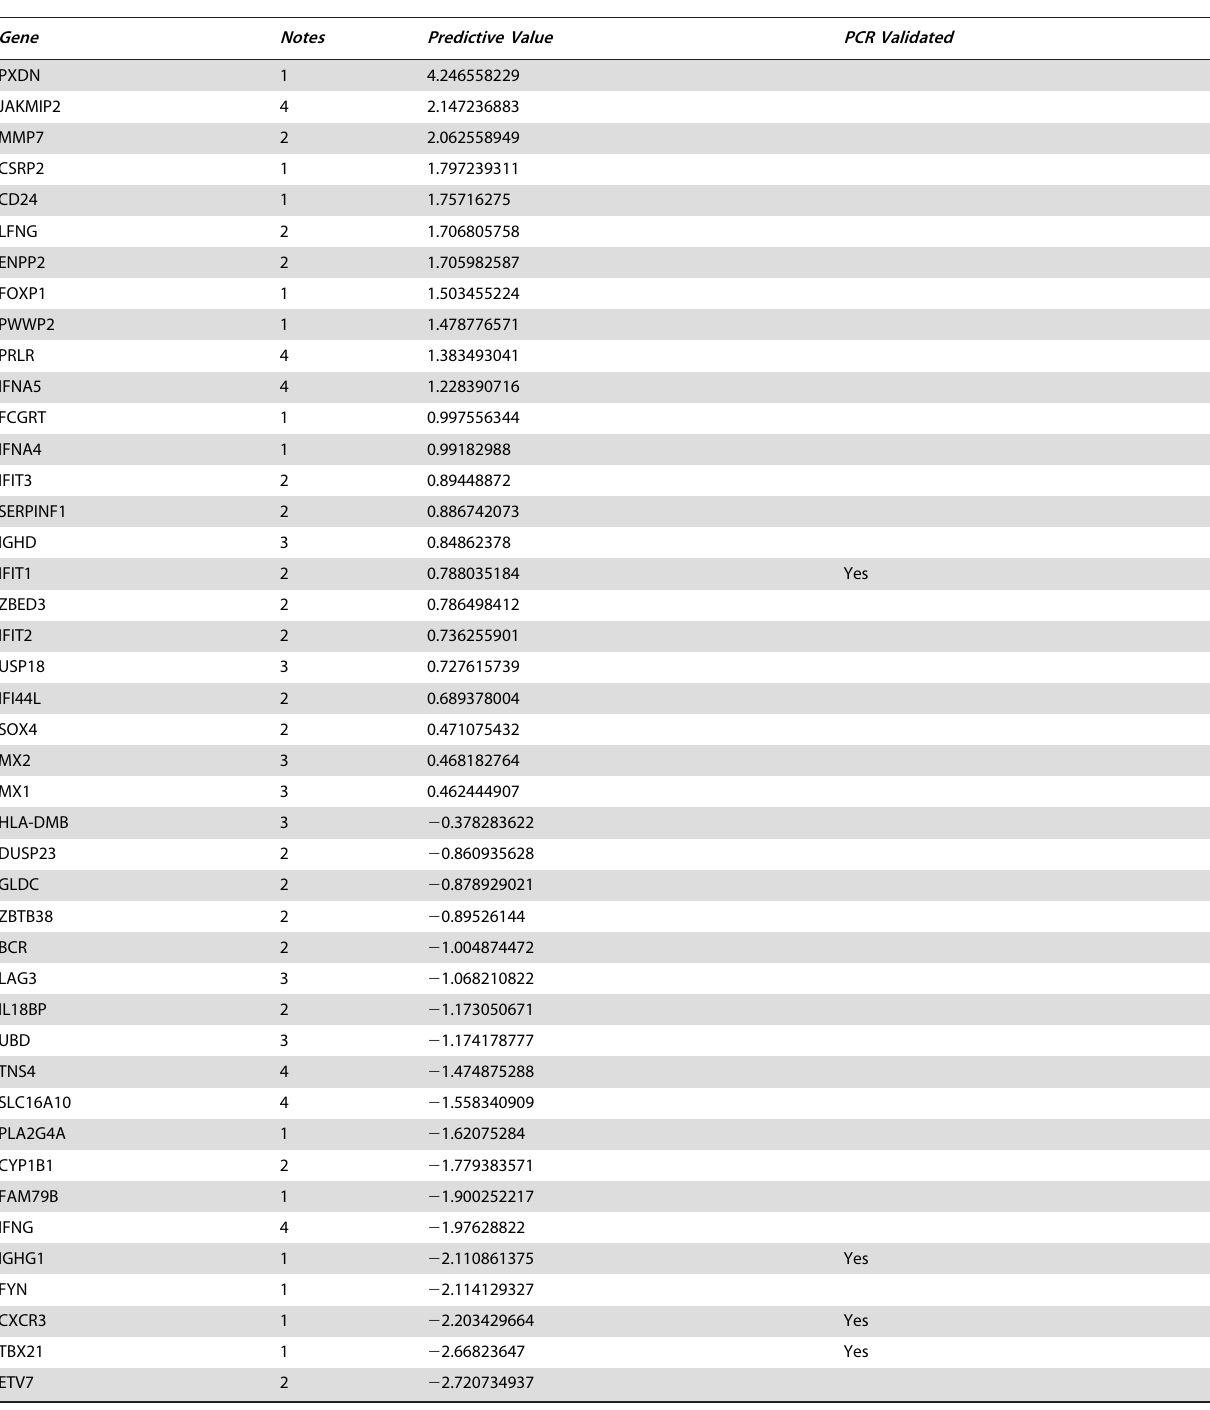
Table 2. List of genes identified as predicting BRCA1 carrier status.